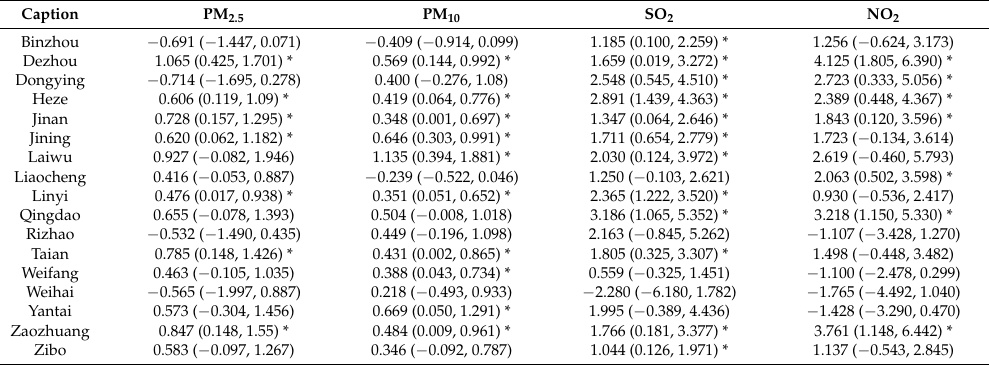
Table A10. Percentage changes of the relative risk of COPD hospitalizations for patients aged over 65 years and their 95% confidence interval (CI) per 10- µ g/m 3 increase in air pollutants in the 17 cities of the Shandong province, where * indicates statistically significant estimates ( p < 0.05).